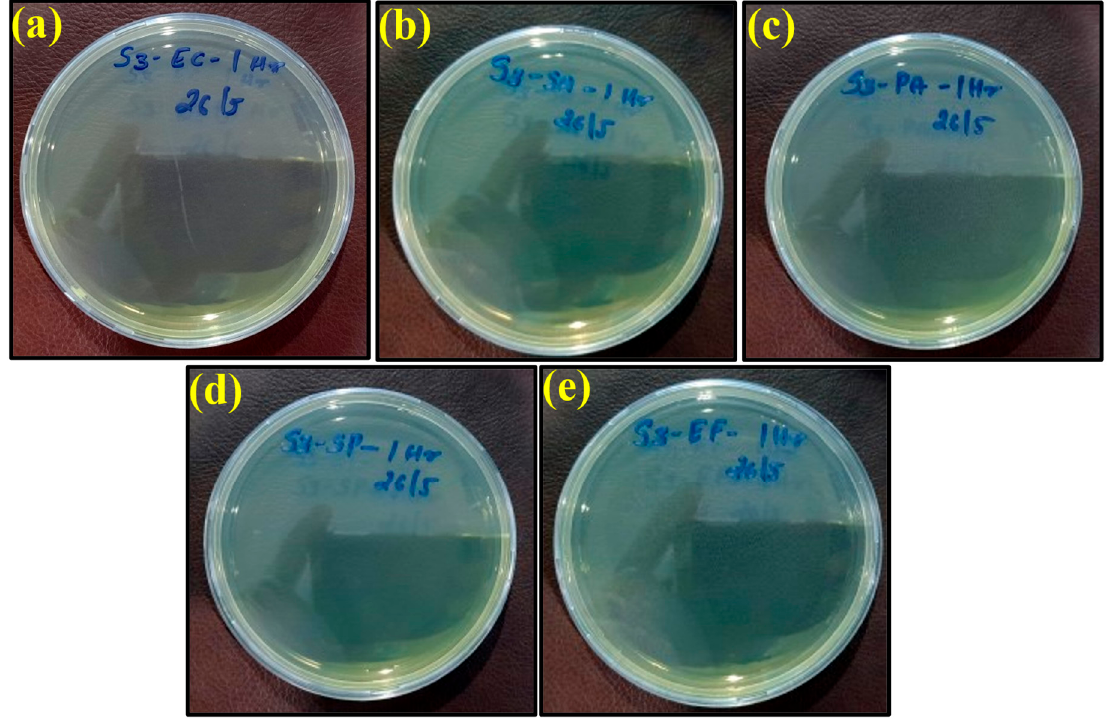
Figure 12. Images of remaining bacteria on PLA/bronze sheet after cultivation for 1 h: ( a ) E. coli ; ( b ) S. aureus ; ( c ) P. aeruginosa ; ( d ) S. Poona; ( e ) Enterococci .